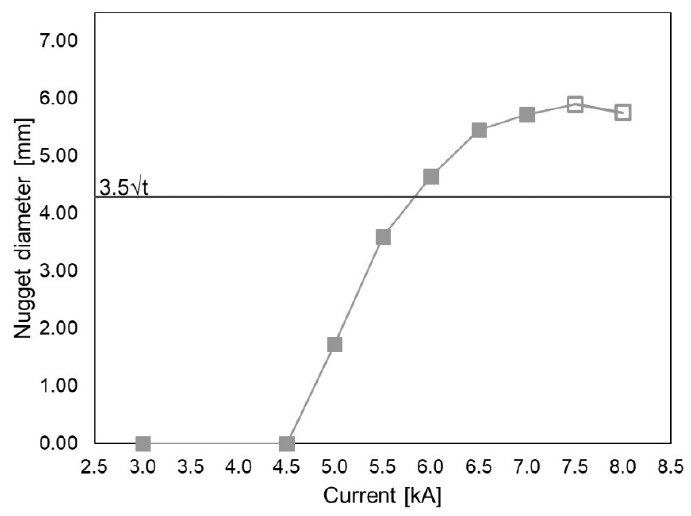
Figure 3. Current range curve with a 0.5 kA step for martensitic steel with a Zn jet vapor-deposited coating in accordance with ISO 14327 conditions.